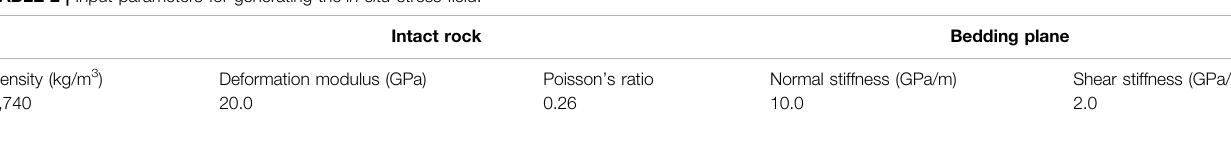
TABLE 2 | Input parameters for generating the in situ stress fi eld.